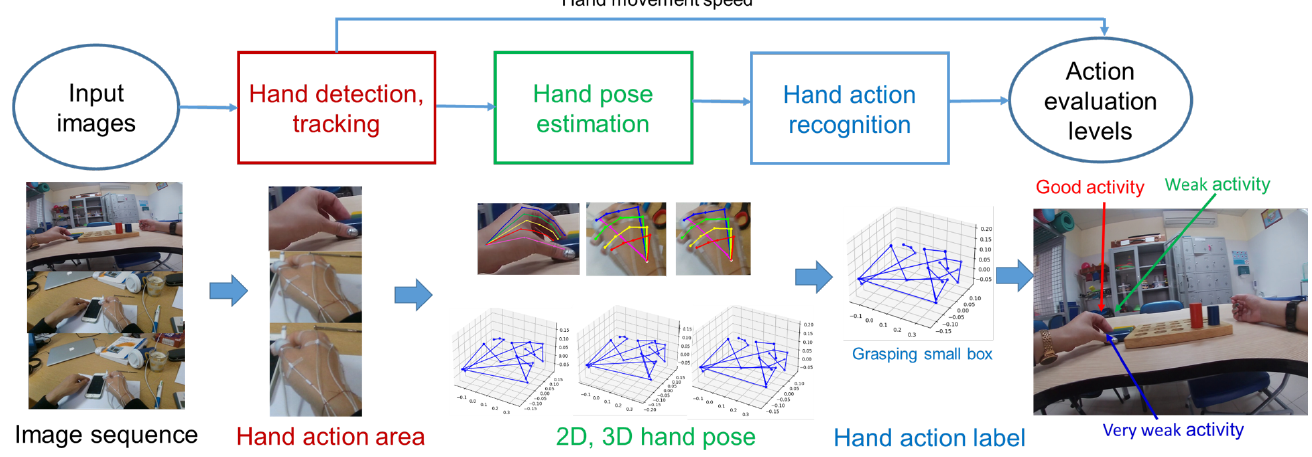
Figure 1. Framework for building an image-based rehabilitation evaluation system of the EV. Hand detection and classification is an important pre-processing step to limit the hand data area for hand pose estimation and activity recognition to assess hand activity levels.